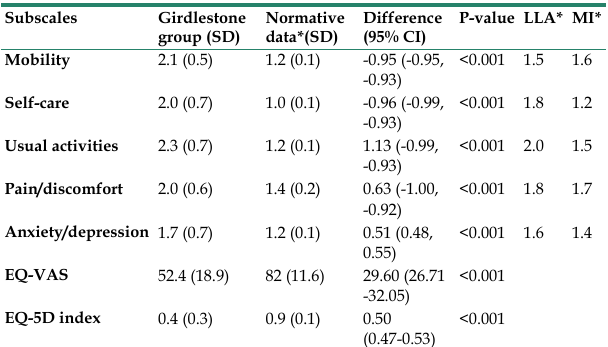
Table 3. Health status scores as assessed with the EQ-5D-3L domain compared to normative data and disease specific entities. Mean population EQ-VAS and mean EQ-5D-index.